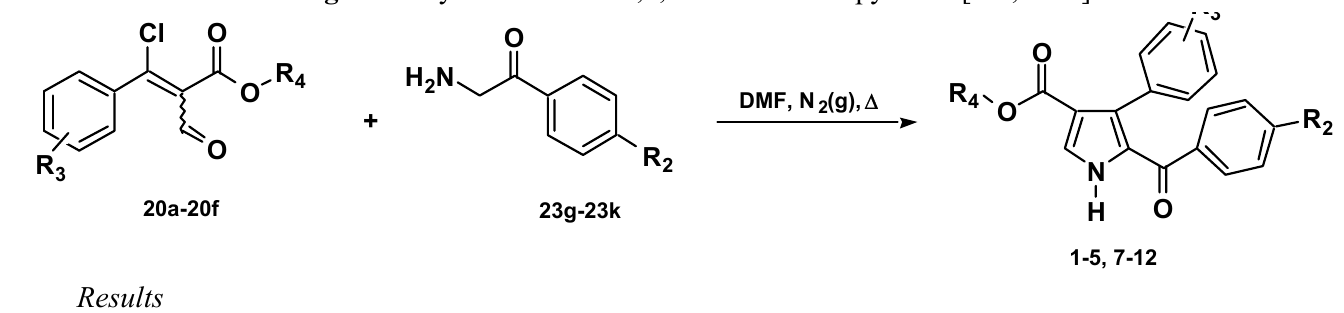
Figure 4: Synthesis of the 2,3,4-trisubstituted pyrroles [1-5, 7-12].